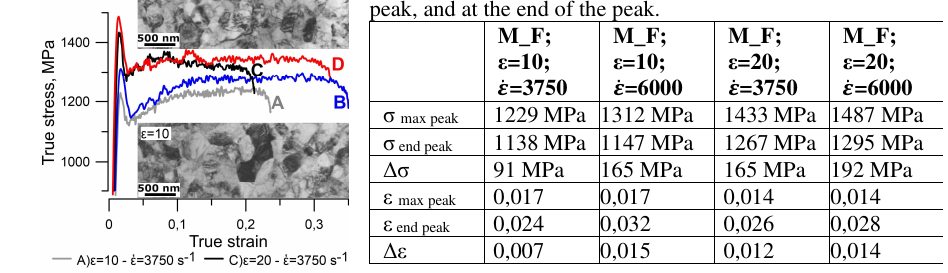
Table.1. Values for stress and strain in the highest point of the peak, and at the end of the